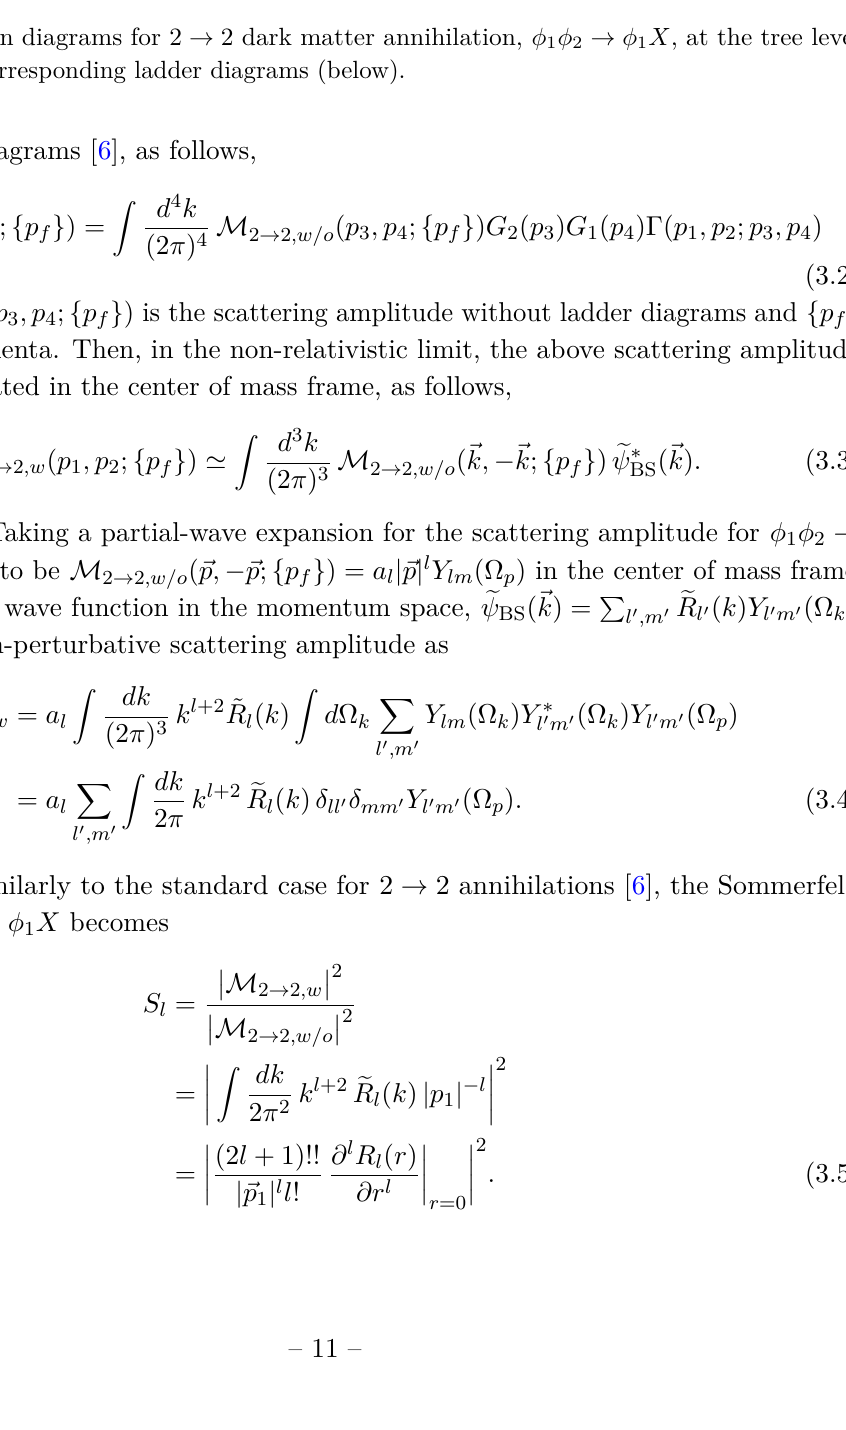
2 dark matter annihilation, φ 1 φ 2 →